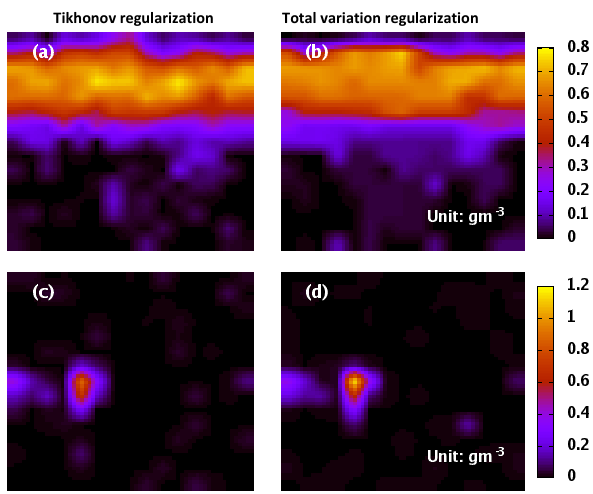
Figure 4. The cloud liquid water fields retrieved using the airborne cloud tomography Fig. 4. The cloud liquid water fields retrieved using the airborne setup with the total variation regularization and the standard Tikhonov regularization. (a) Stratocumulus case using the Tikhonov regularization; (b) Stratocumulus case using the cloud tomography setup with the total variation regularization and total variation regularization; (c) Puffy cumulus case using the Tikhonov regularization; the standard Tikhonov regularization. (a) stratocumulus case using and (d) Puffy cumulus case using the total variation regularization. the Tikhonov regularization; (b) stratocumulus case using the total variation regularization; (c) puffy cumulus case using the Tikhonov regularization; and (d) puffy cumulus case using the total variation